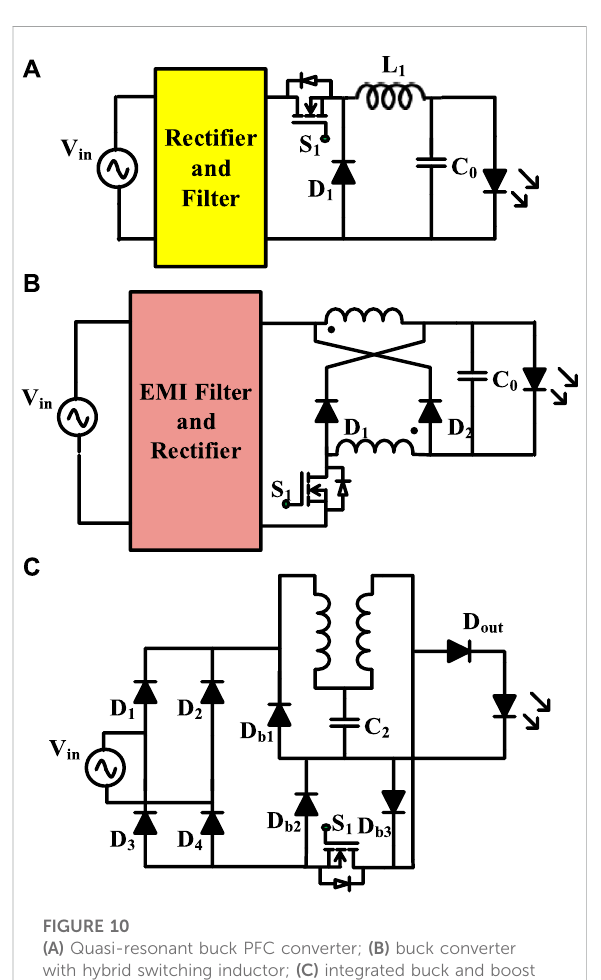
FIGURE 10 (A) Quasi-resonant buck PFC converter; (B) buck converter with hybrid switching inductor; (C) integrated buck and boost converter.